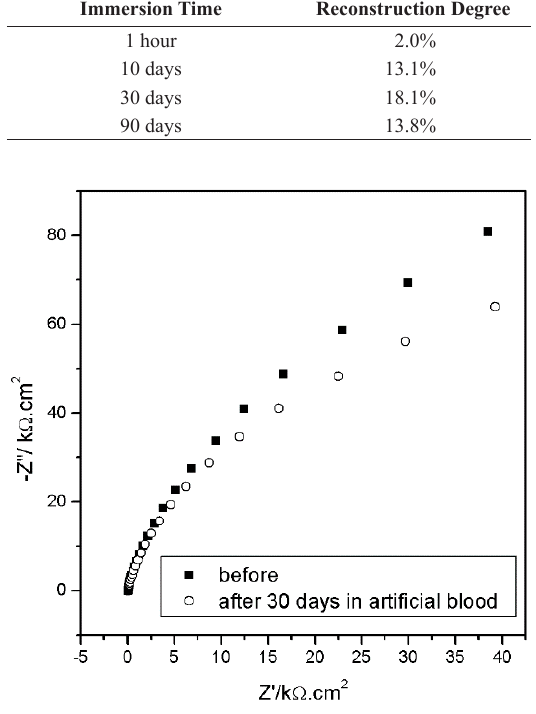
Figure 2. Nyquist plot for Ti6Al4V/oxide grown at 5.0 V in PBS before and after immersion in artificial blood for 30 days at room temperature. The dc potential was the open circuit potential: ~0.380 V.